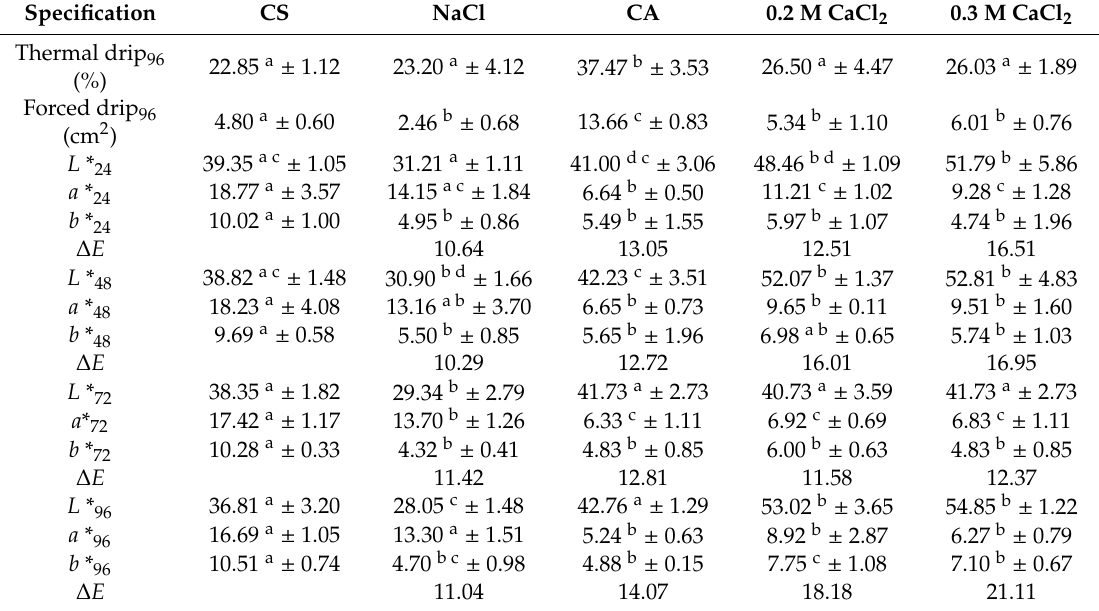
Table 3. Selected hydration properties and parameters of horse meat color during cold storage ( x ±